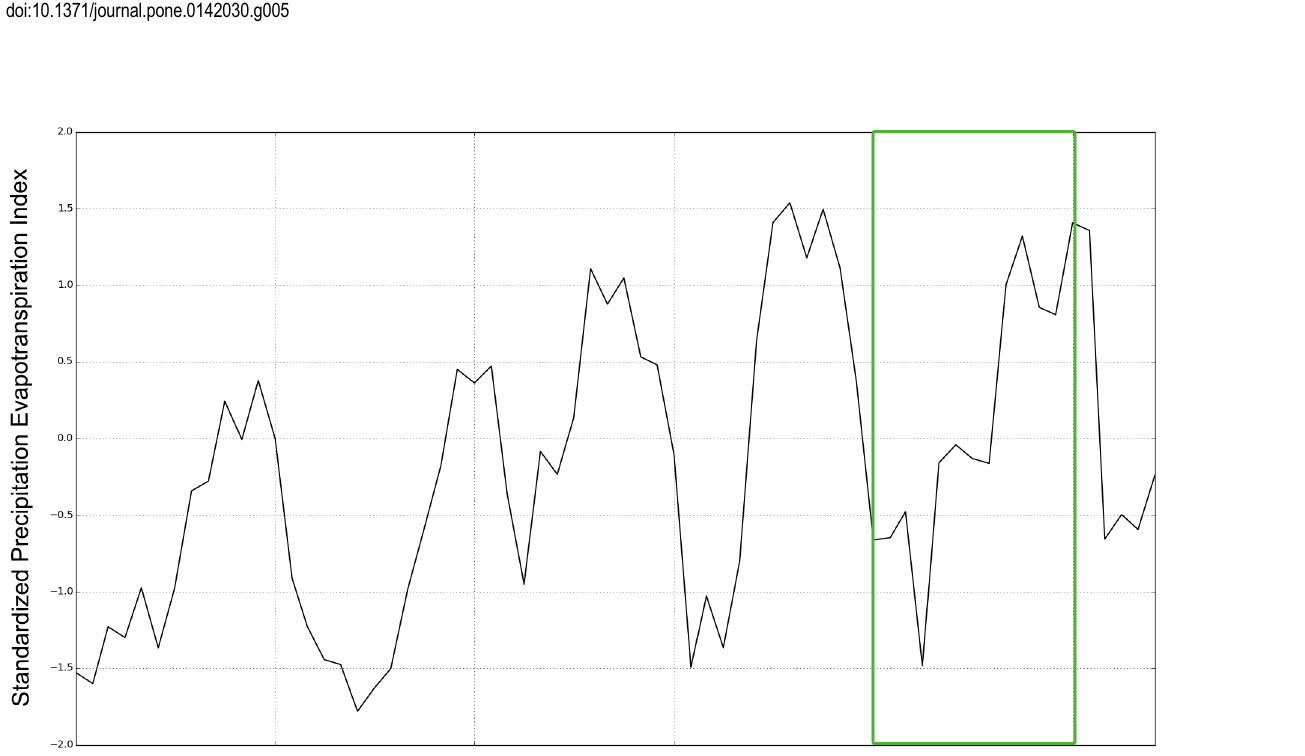
PLOS ONE | DOI:10.1371/journal.pone.0142030 November 18,